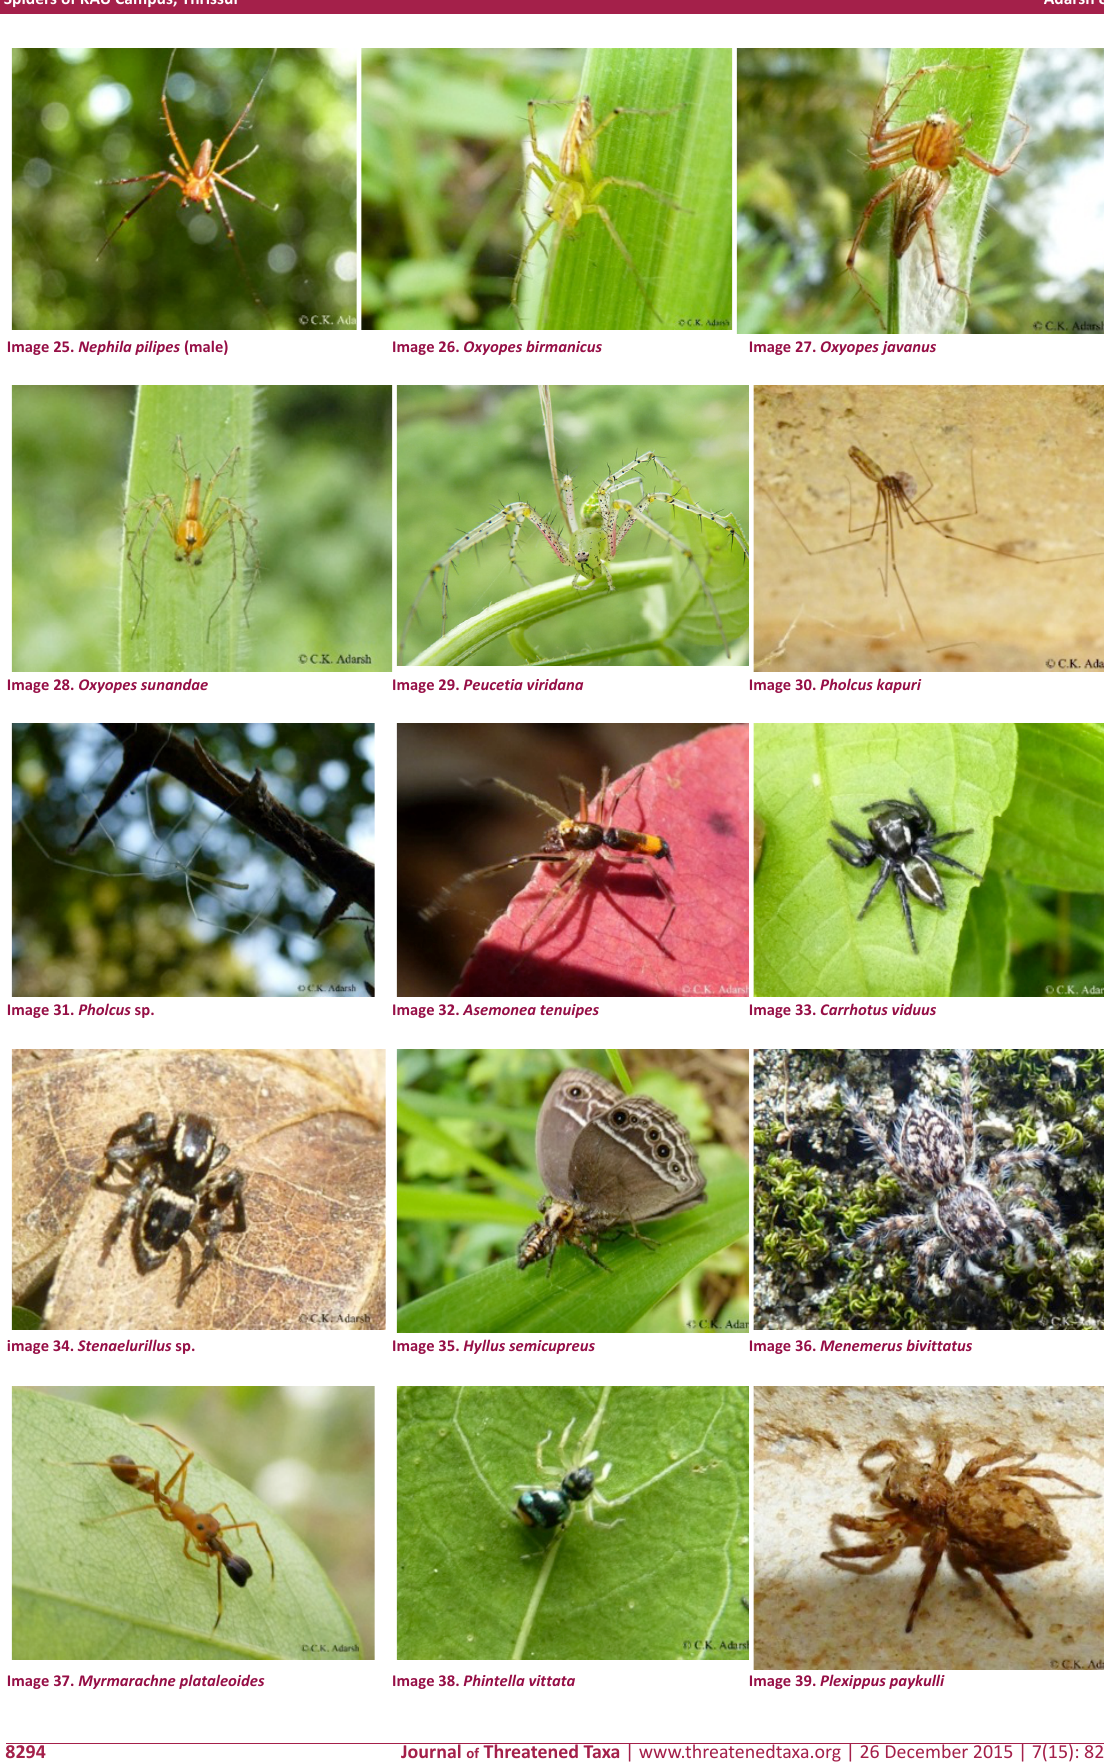
Image 37. Myrmarachne plataleoides Image 38. Phintella vittata Image 39. Plexippus